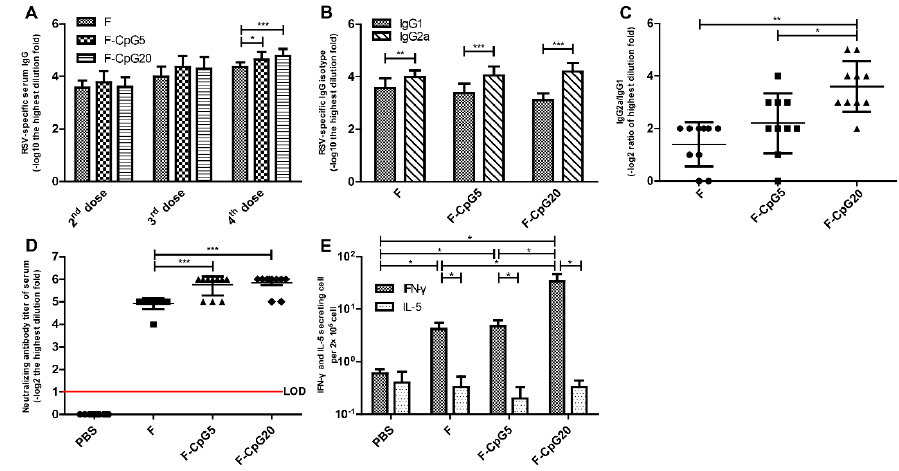
Figure 2. The induced RSV-specific immune responses in mice immunized with CpG-C modified DNA plasmids. BALB/c mice ( n = 5) were immunized 4 times via i.m. route with either pVAX1-F (30 μ g/dose/mouse), pVAX1-F-CpG5 (30 μ g/dose/mouse), pVAX1-F-CpG20 (30 μ g/dose/mouse), or PBS (negative control, NC, 100 μ L/mouse). The serologic results for the two independent experiments were similar so data from both are included in Panels ( A – D ). ( A ) Serum total immunoglobulin (Ig) G antibody titers; ( B ) IgG isotype antibody titers; ( C ) the ratio of IgG2a/IgG1 isotype antibody titers depicted in panel ( B ); ( D ) serum neutralizing antibody titers expressed as the reciprocal of the highest serum dilution giving 50% reduction of plaque numbers relative to no antibody control well. The red line is the limit of detection (LOD); ( E ) RSF F-specific ELISPOT immune responses as number of positive spots/2 × 10 5 splenocytes for interferon gamma (IFN- γ ) or inteleukin (IL)-5 at 7 days after the last, 4th, vaccine dose. The data are the mean ± standard deviation (SD). Significance was determined by a Student’s t -test in GraphPad Prism, and with each point of data representing one individual animal. * p < 0.05, ** p < 0.01, *** p < 0.001. F: pVAX1-F; F-CpG5: pVAX1-F-CpG5; F-CpG20: